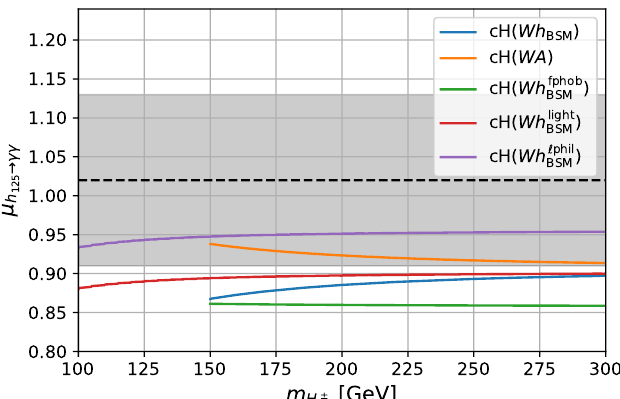
Figure 24. Di-photon rate of h 125 for the fermionic production modes (ggF+bbH) in dependence of m for the various benchmark scenarios defined in section 5. The dashed line indicates the H ± central value of the latest ATLAS measurement [117], the shaded region is the corresponding 1 σ uncertainty and the displayed µ range corresponds to the 2 σ uncertainty region (assuming h 125 → γγ a Gaussian